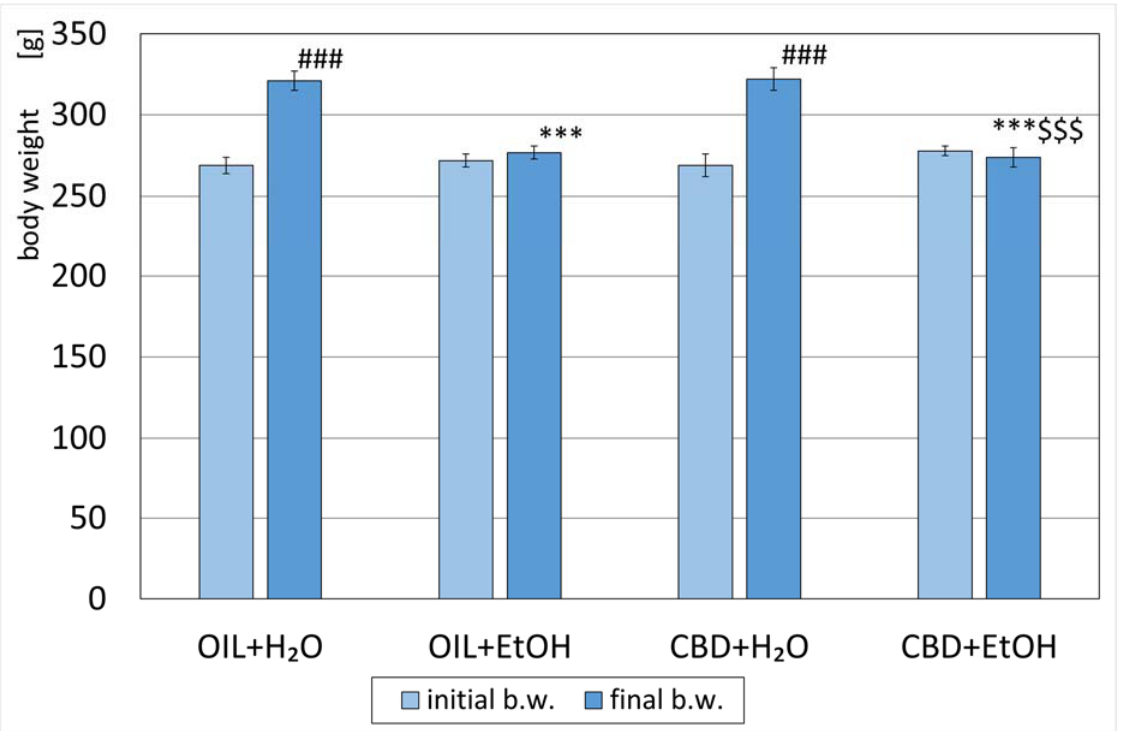
Figure 2. Initial (day 1) and final (day 8) body weights of rats treated with OIL (rapeseed oil) or CBD (cannabidiol; 20 mg. kg, p.o.) and H 2 O (water for injection) or EtOH (ethanol; 3.0 g/kg/day, i.p.). Mean ± SEM, n = 9; Legend: ***—statistically significant vs. the final weight of the OIL + H 2 O group, p < 0.001; ###—statistically significant vs. the initial weight within a given group, p < 0.001; $$$— statistically significant vs. CBD + H 2 O group, p < 0.001.